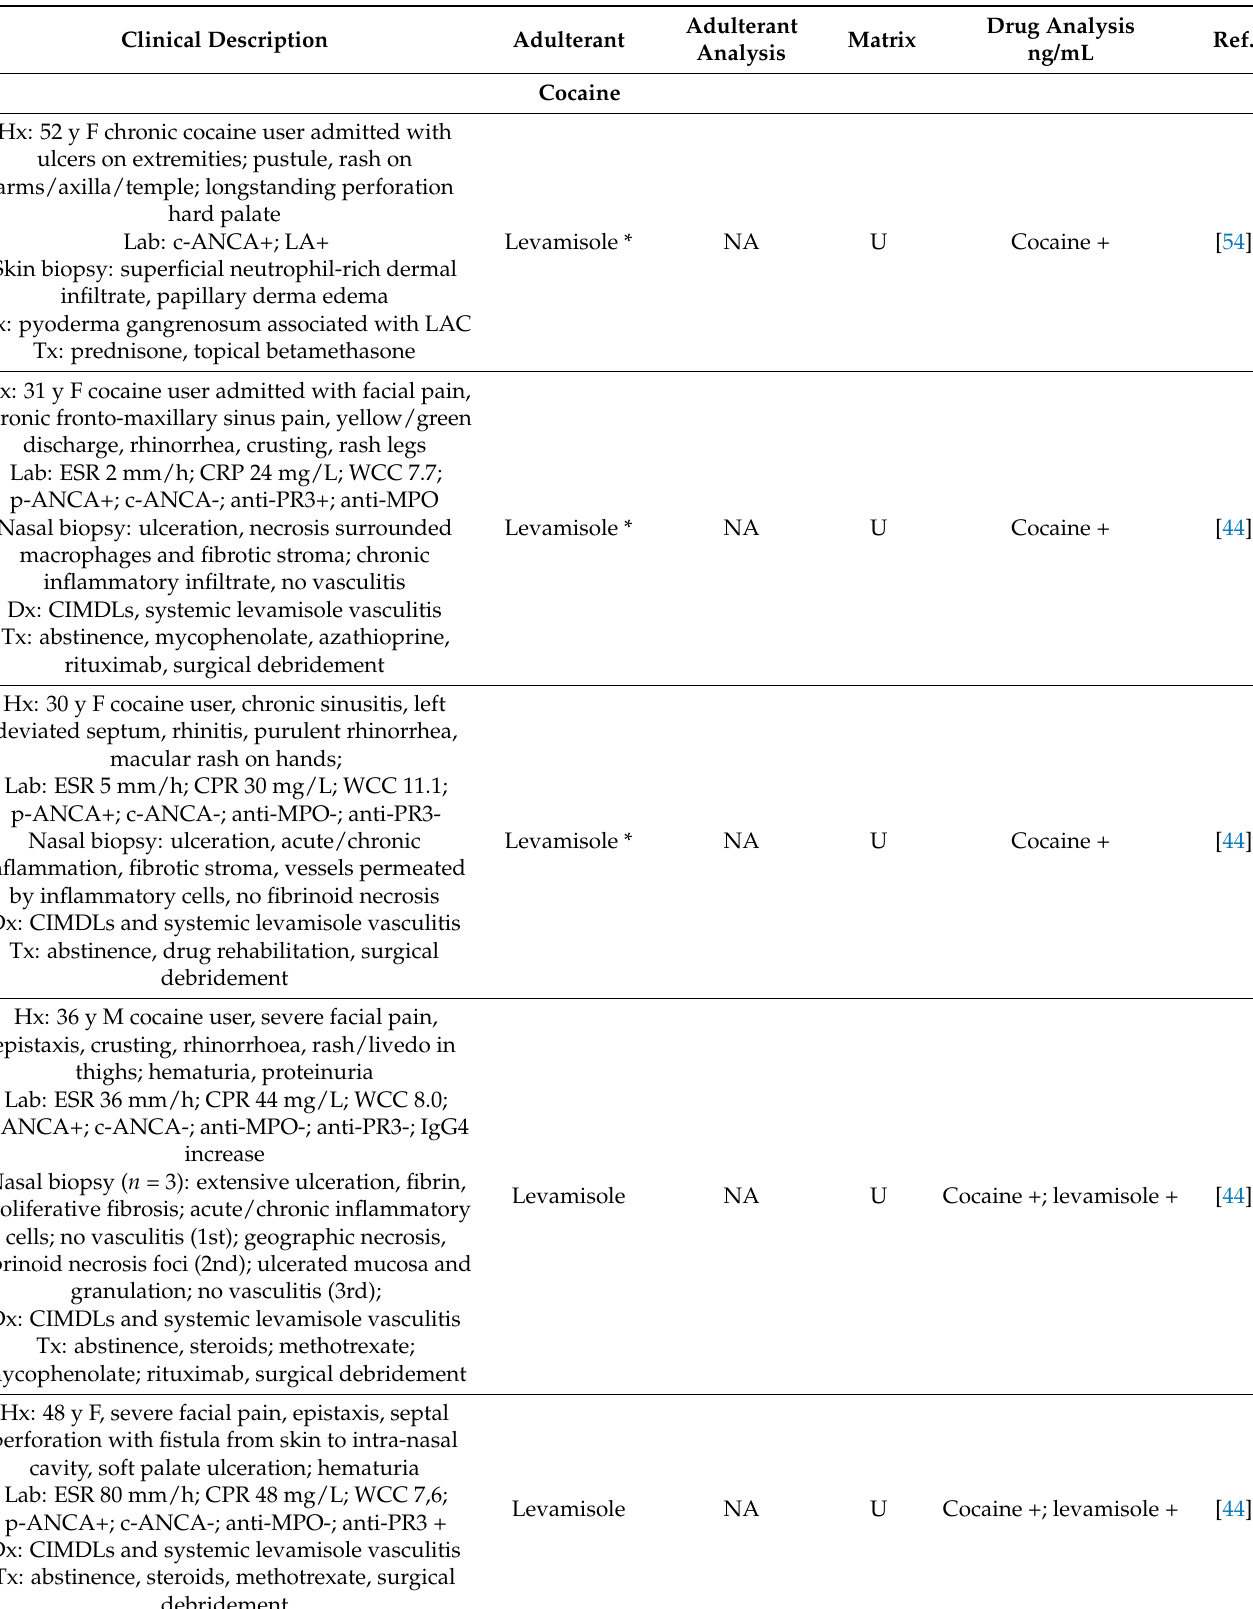
Table 2. Clinical symptoms of authentic cases of adulterated cocaine, heroin and new psychoactive substances (NPS) intoxications reported in the literature between 2017 and